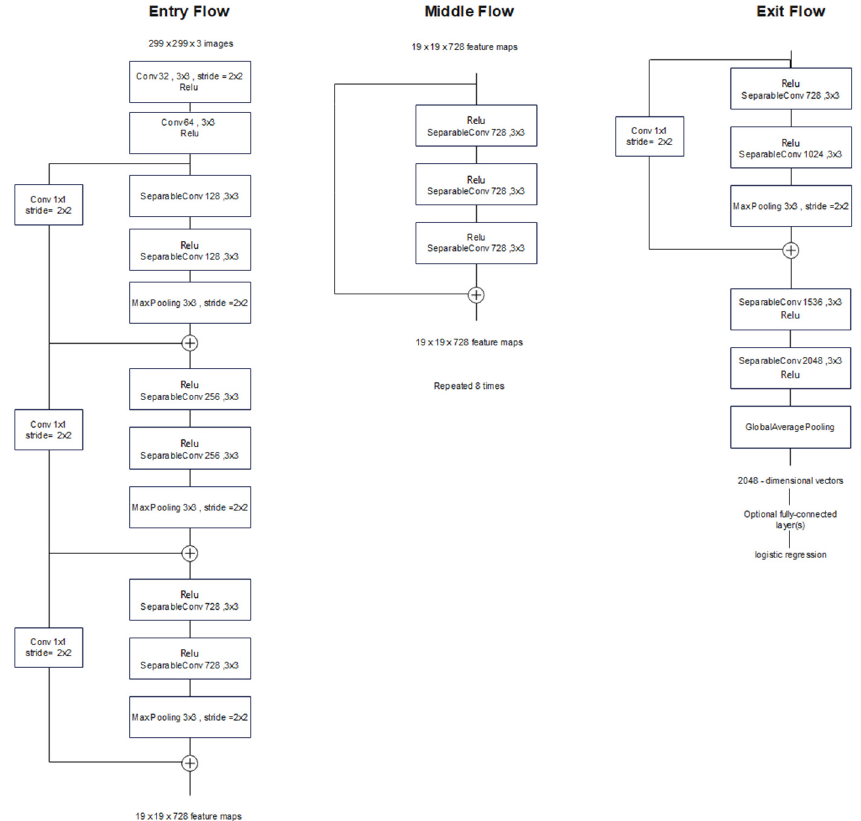
Figure 8. Xception architecture; the input data flow is divided into three parts, starting with the entry flow then moving through the middle flow and ending with the exit flow.